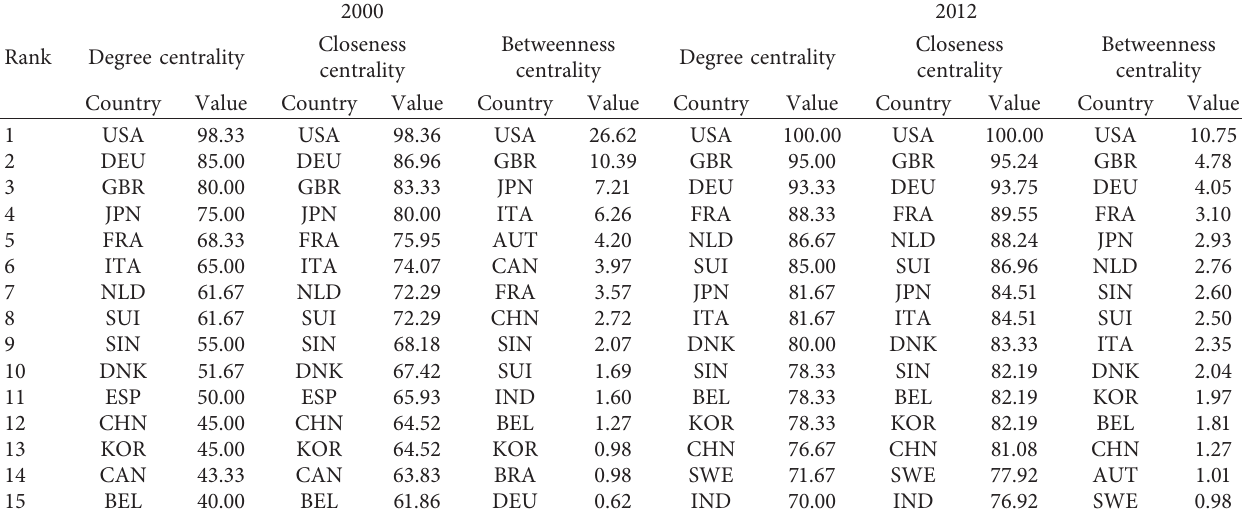
Table 4: Centrality analysis of the producer services trade network (Top